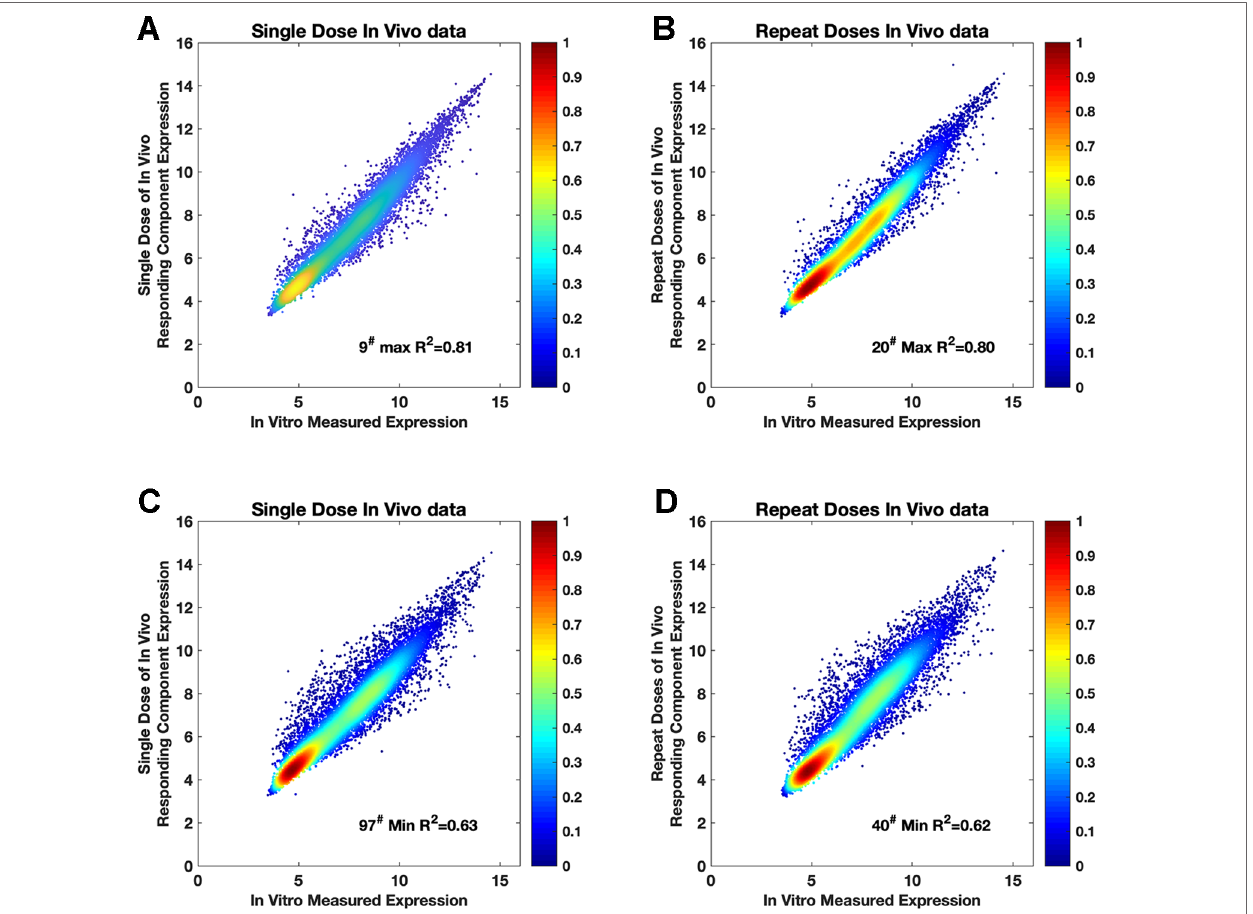
FIGURE 3 | The intensity scatter plots re fl ecting the consistency between in vivo and in vitro data. (A and C) Intensity scatter plots for the compounds that have max R 2 (R 2 = 0.81, RMSE = 3.96) and min R2 (R 2 = 0.63, RMSE = 3.97) in single-dose in vivo data. (B and D) Plots for the compounds that have max R 2 (R 2 = 0.80, RMSE = 4.00) and min R2 (R 2 = 0.62, RMSE = 3.96) in repeat-doses in vivo data. 9 # , 20 # , 97 # , and 40 # are acetaminophen, captopril, quinidine, and disopyramide, respectively. Purple color and yellow color in this fi gure indicate data from the single-dose and repeat-doses systems,